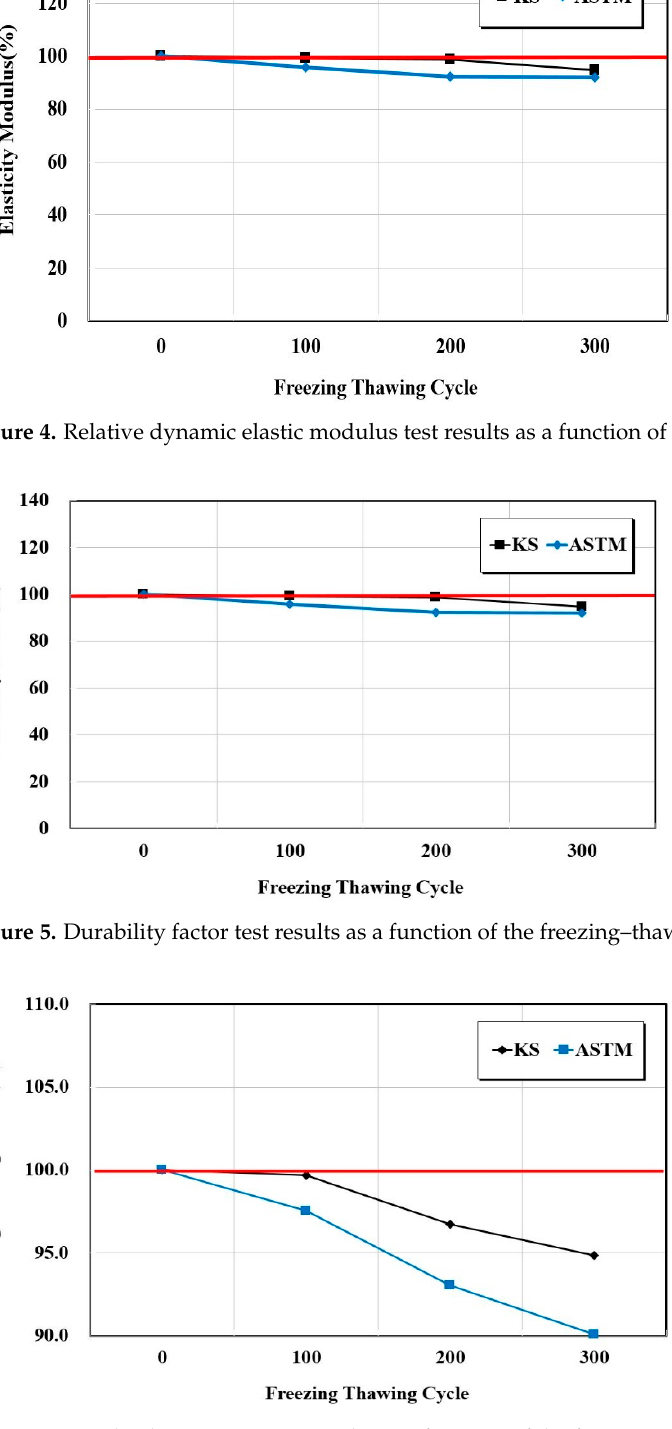
Figure 7. Compressive strength test results based on the KS and ASTM standards at the 0th and 300th freezing–thawing cycles. 4. Performance Test of Structure Restoration Materials 4.1. Structure Restoration Material Performance Analysis (KS, ASTM) Structure restoration materials were used to fill a defect area after removing an un- sound area of concrete to eliminate problems of adhesion to concrete and the intrusion of deterioration factors. Polymer-cement mortar was mainly used with spray and prepack concrete methods applied in case of large defect areas. Furthermore, for cross-sectional restoration after exposure of the rebar, such as the rebar antirust treatment, polymer ce- ment mortar, and concrete, which have material properties close to cement and concrete, are often used considering the corrosion of rebar. Lastly, when repairing structures with a large repair cross-section, a structure restoration material that has similar mechanical properties as the concrete of the repair part needs to be selected. The performance analysis test used for structure restoration materials was performed in accordance with the test standards and methods based on two types of polymer cement repair mortars, as shown in Table 5.